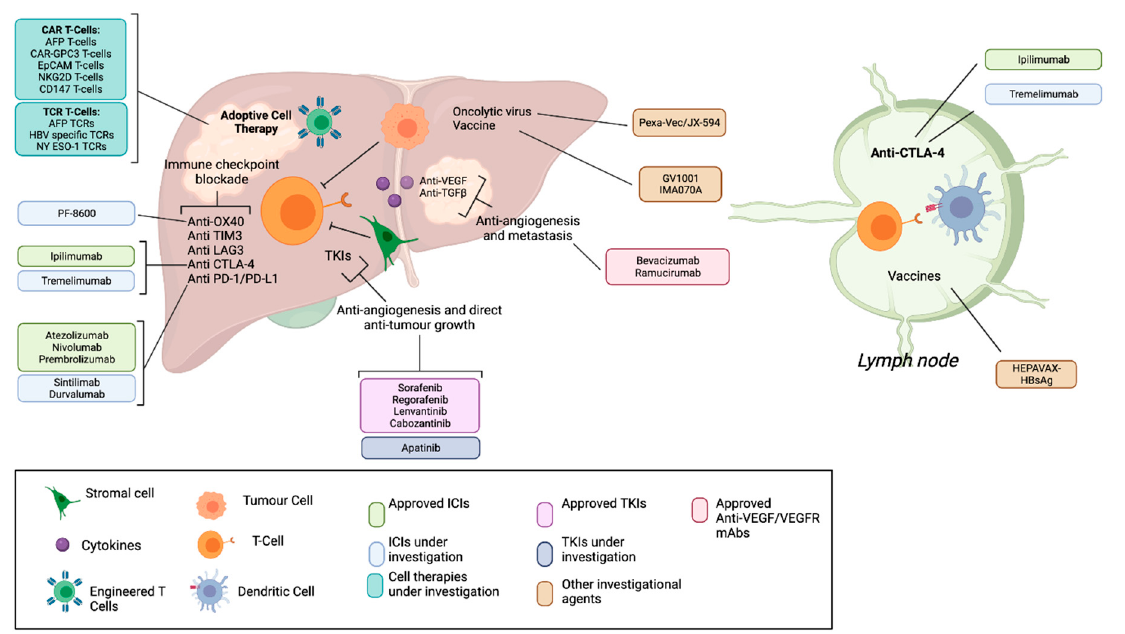
Figure 1. Immune-based and TKI therapies for HCC. Approved drugs and investigational agents are listed, including checkpoint inhibitors (ICIs), adoptive T cell therapies, small molecule inhibitors of angiogenesis and tumour growth, monoclonal antibodies targeting angiogenesis and oncolytic viruses and vaccines.